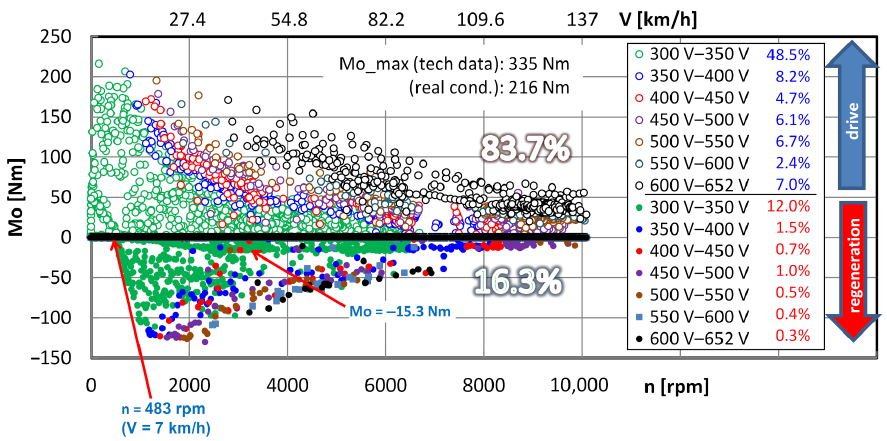
Figure 12. Characteristics of an electric motor in relation to its operating